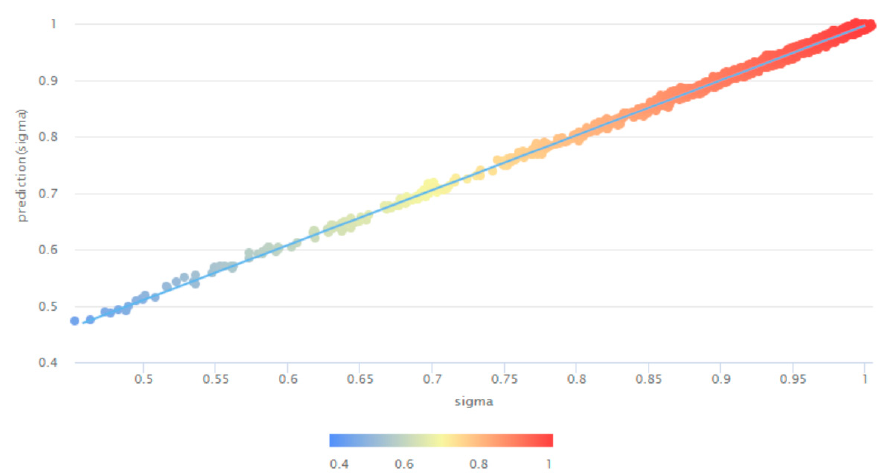
Figure 8. The prediction chart of the membership values of power dissipation (sigma) at subtracting amplifier design.